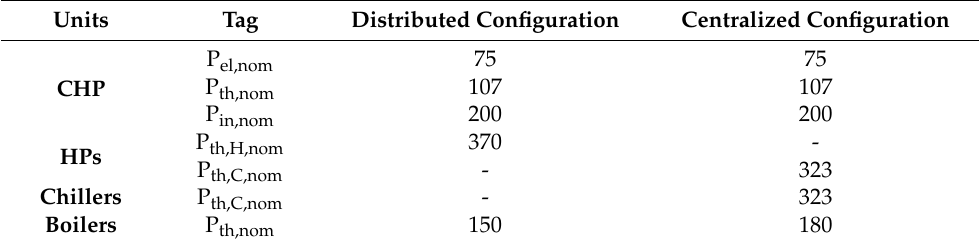
Table 5. Optimal sizes for the distributed and centralized configurations, kW.